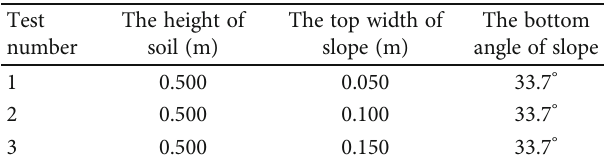
Table 1: List of